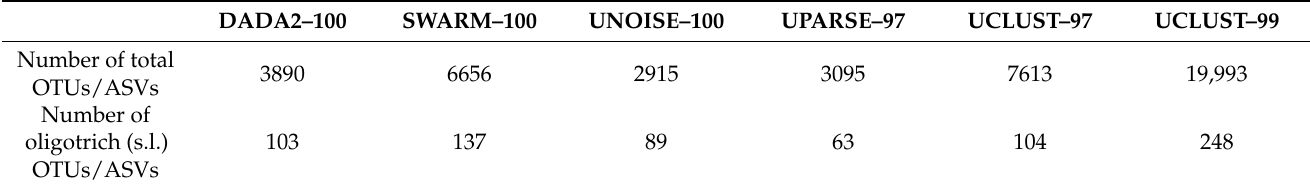
Table 1. The number of total and oligotrich (s.l.) OTUs/ASVs in six datasets.